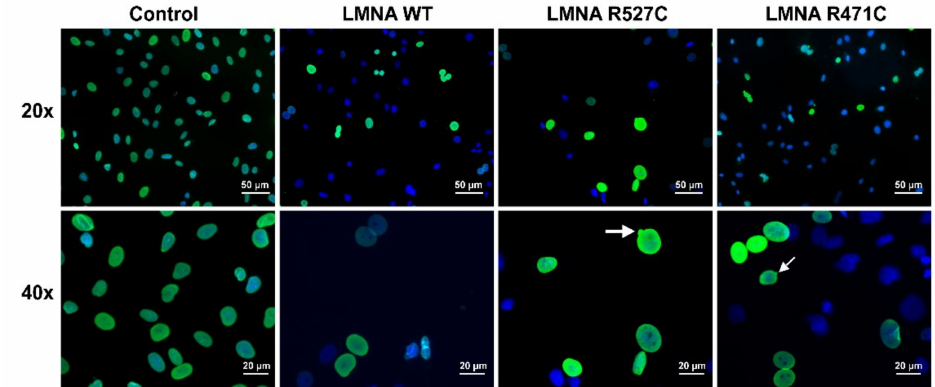
Figure 1. Verification of transgene LMNA expression in CMC. RCMC were infected with saturating concentrations of lentiviruses bearing human LMNA WT or LMNA R527C/R471 C genes. The cells were stained with anti lamin A antibody recognizing only human lamin A. Upper row: 20 × magnification; lower raw 40 × magnification. HCMC were used as a control (Control) and give uniform nuclear staining of lamin A at the nuclear rim. Transduction of RCMC with lentivirus-bearing human LMNA WT shows nuclei with normal appearance and without any blebbing (LMNA WT). Transduction of RCMC with lentivirus bearing human LMNA R527L and LMNA R471C shows nuclear blebbing in some of the transduced cells as an effect of the